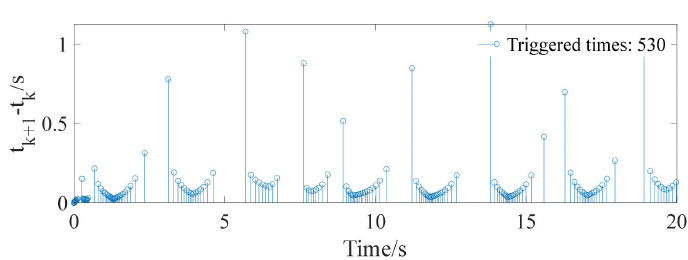
Figure 5. Triggered interval.